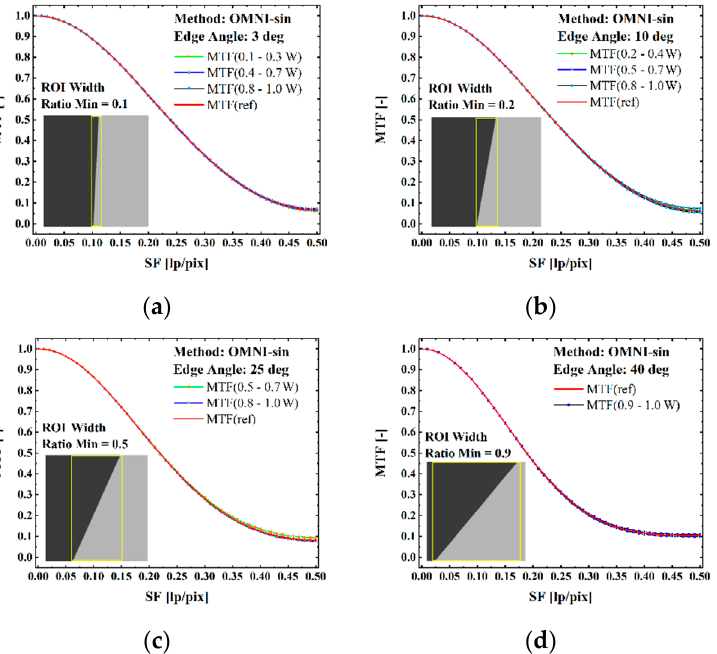
Figure 12. MTF for some tilt angle BDE images when adopt different ROI width using OMNI-sin edge method: ( a ) when edge angle is 3 deg, ( b ) when edge angle is 10 deg, ( c ) when edge angle is 25 deg, ( d ) when edge angle is 40 deg.